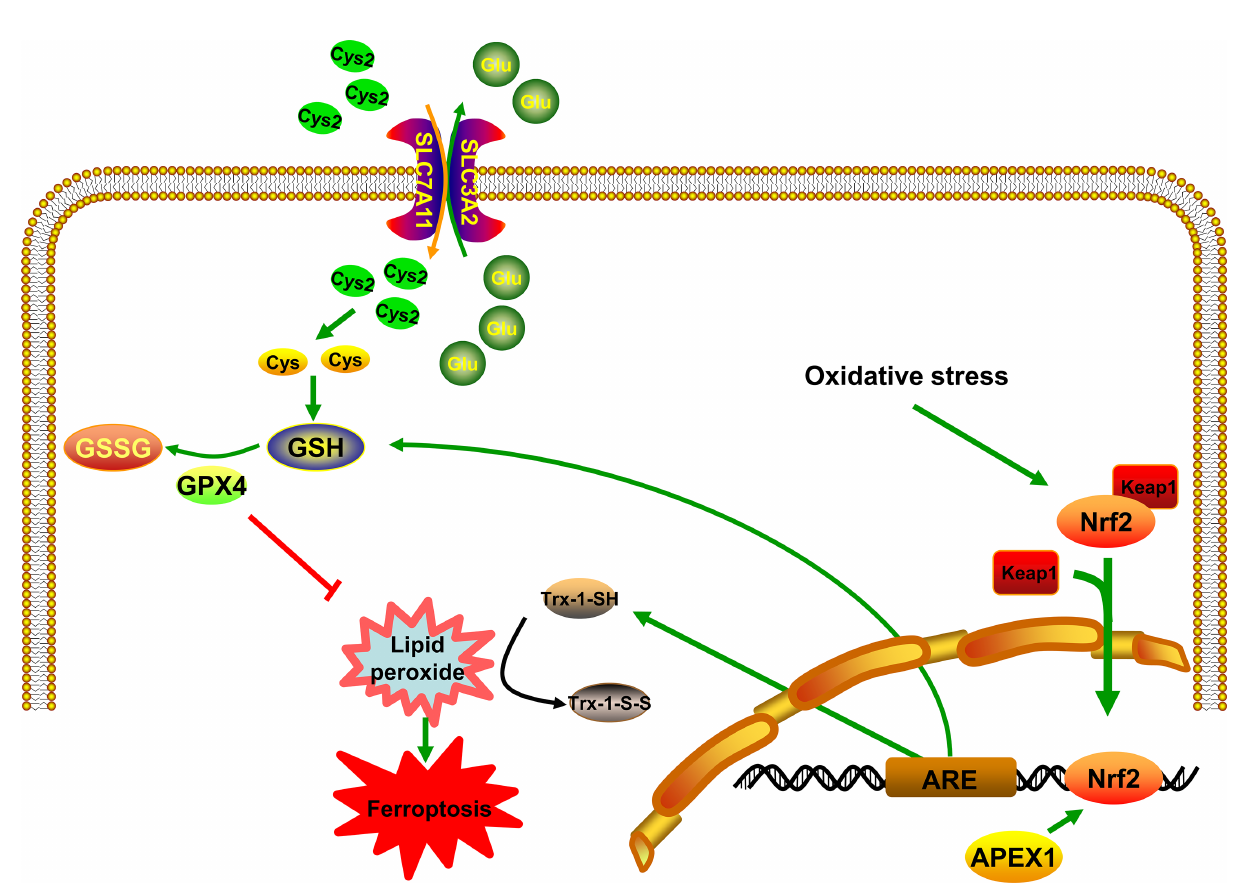
FIGURE 1 | APEX1 inhibits ferroptosis by regulating Nrf2/ARE pathway. APEX1 induces the expression of ARE by regulating the activity of Nrf2. Trx-1 and GSH resist the accumulation of lipid peroxidation through its sulfhydryl